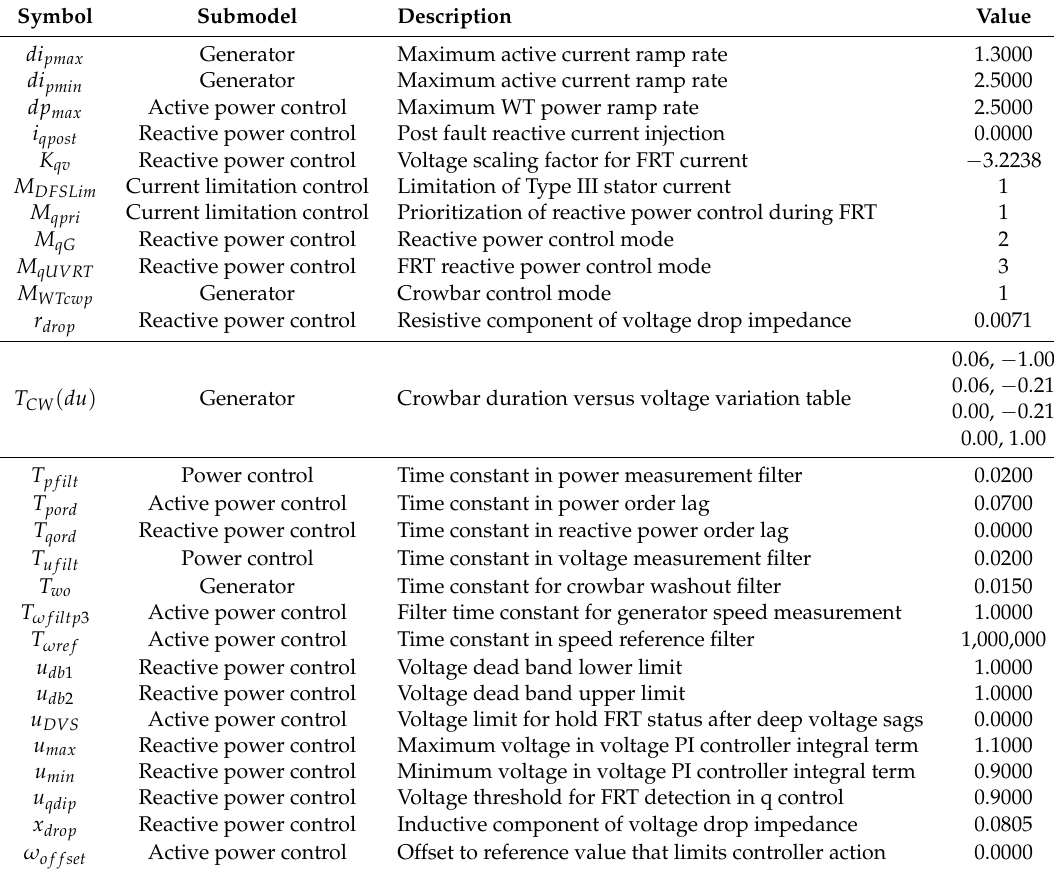
Table A1. Parameters for the generic IEC Type IIIB